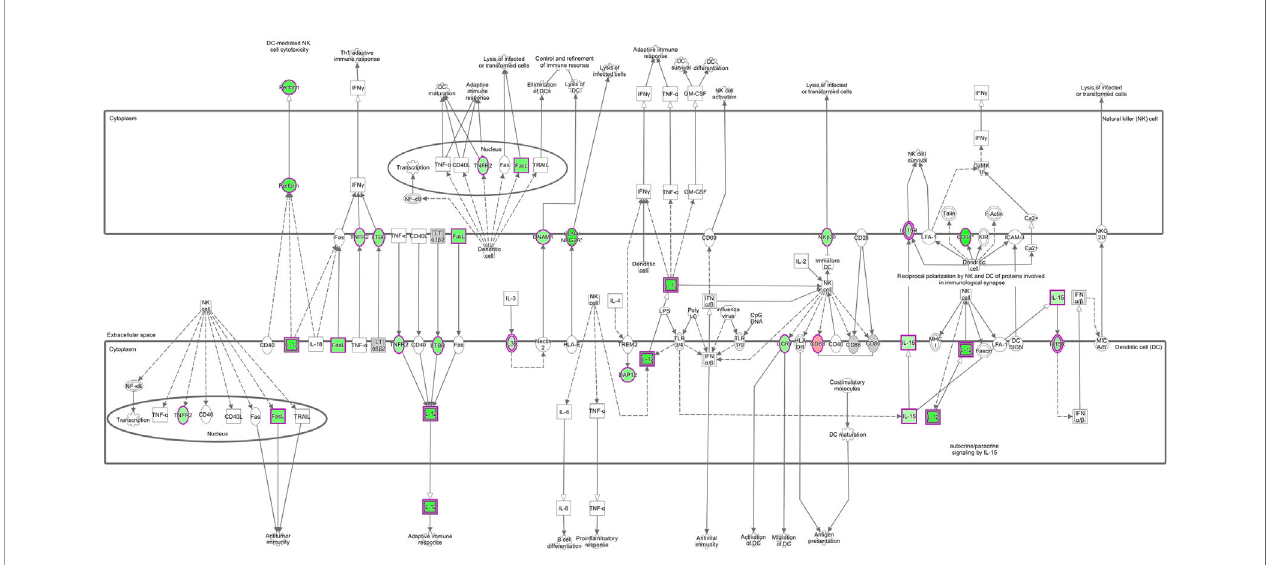
FIGURE 3 | Crosstalk between DC and NK. Pathway represented with gene expression (log 2 fold-change) values overlaid. Red shading indicates increased and green shading indicates decreased, while colour intensity indicates expression level. White and grey shading indicate not signi fi cantly differentially expressed and fi ltered out due to low expression, respectively. Solid and dashed lines represent direct and indirect interactions, respectively, between molecules. Open arrow means ‘ translocate to ’ , solid arrow means ‘ acts on ’ . Shapes indicate functional class of a gene product; vertical ellipse (transmembrane receptor), horizontal ellipse (transcription regulator), square (cytokines), circle (others), cogwheel (pathways). Double edge indicates complex or group. © 2000 – 2020 QIAGEN. All rights